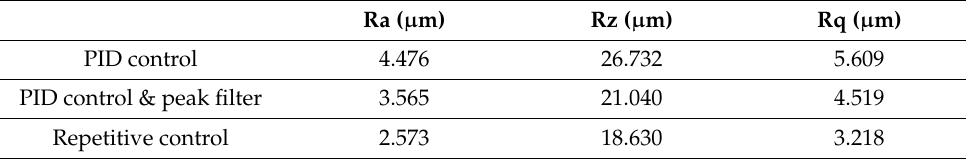
Figure 13. The brass workpiece ( a ) and the grinded workpieces using PID force control ( b ), PID force control with peak filter ( c ), and repetitive control ( d ). Table 5. Surface roughness of the grinded workpieces using three different force control